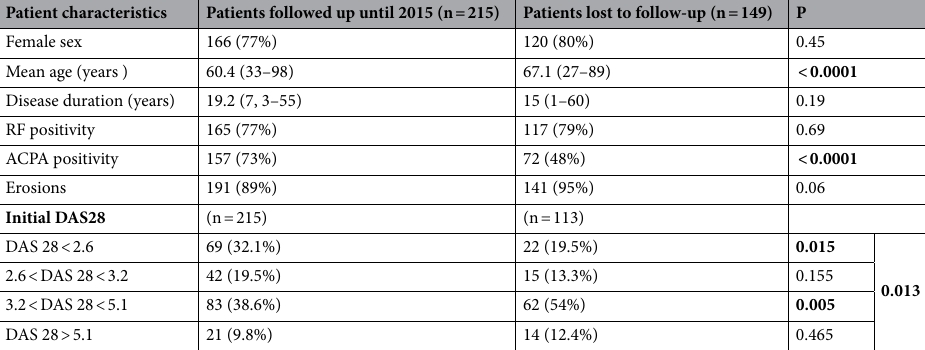
Table 1. Patient characteristics: patients consulting with a Rheumatoid Arthritis in Rheumatology department at the Poitiers University Hospital in 2008 according to their inclusion or not in follow-up. RF rheumatoid factors, ACPA anti-citrullinated peptide antibodies. Significant values are in bold.